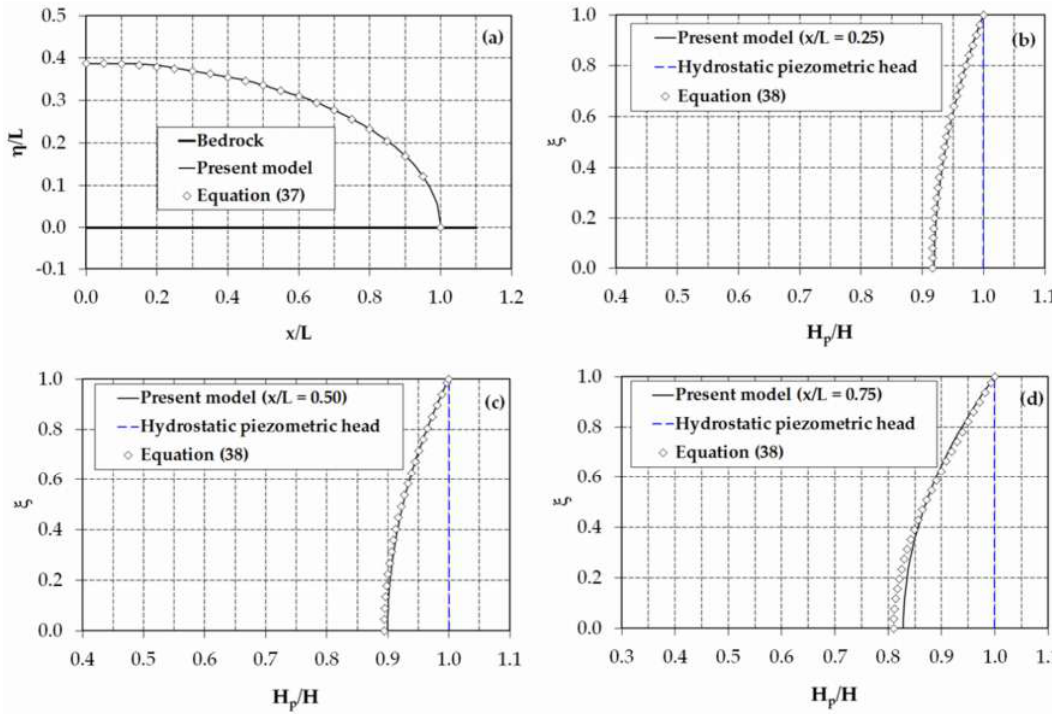
Figure 11. ( a ) Phreatic-surface profile for unconfined flow to a wide flat drain overlying impermeable bedrock. The corresponding vertical distributions of the piezometric head of the flow at various locations: ( b ) x / L = 0.25; ( c ) x / L = 0.50; and ( d ) x / L =